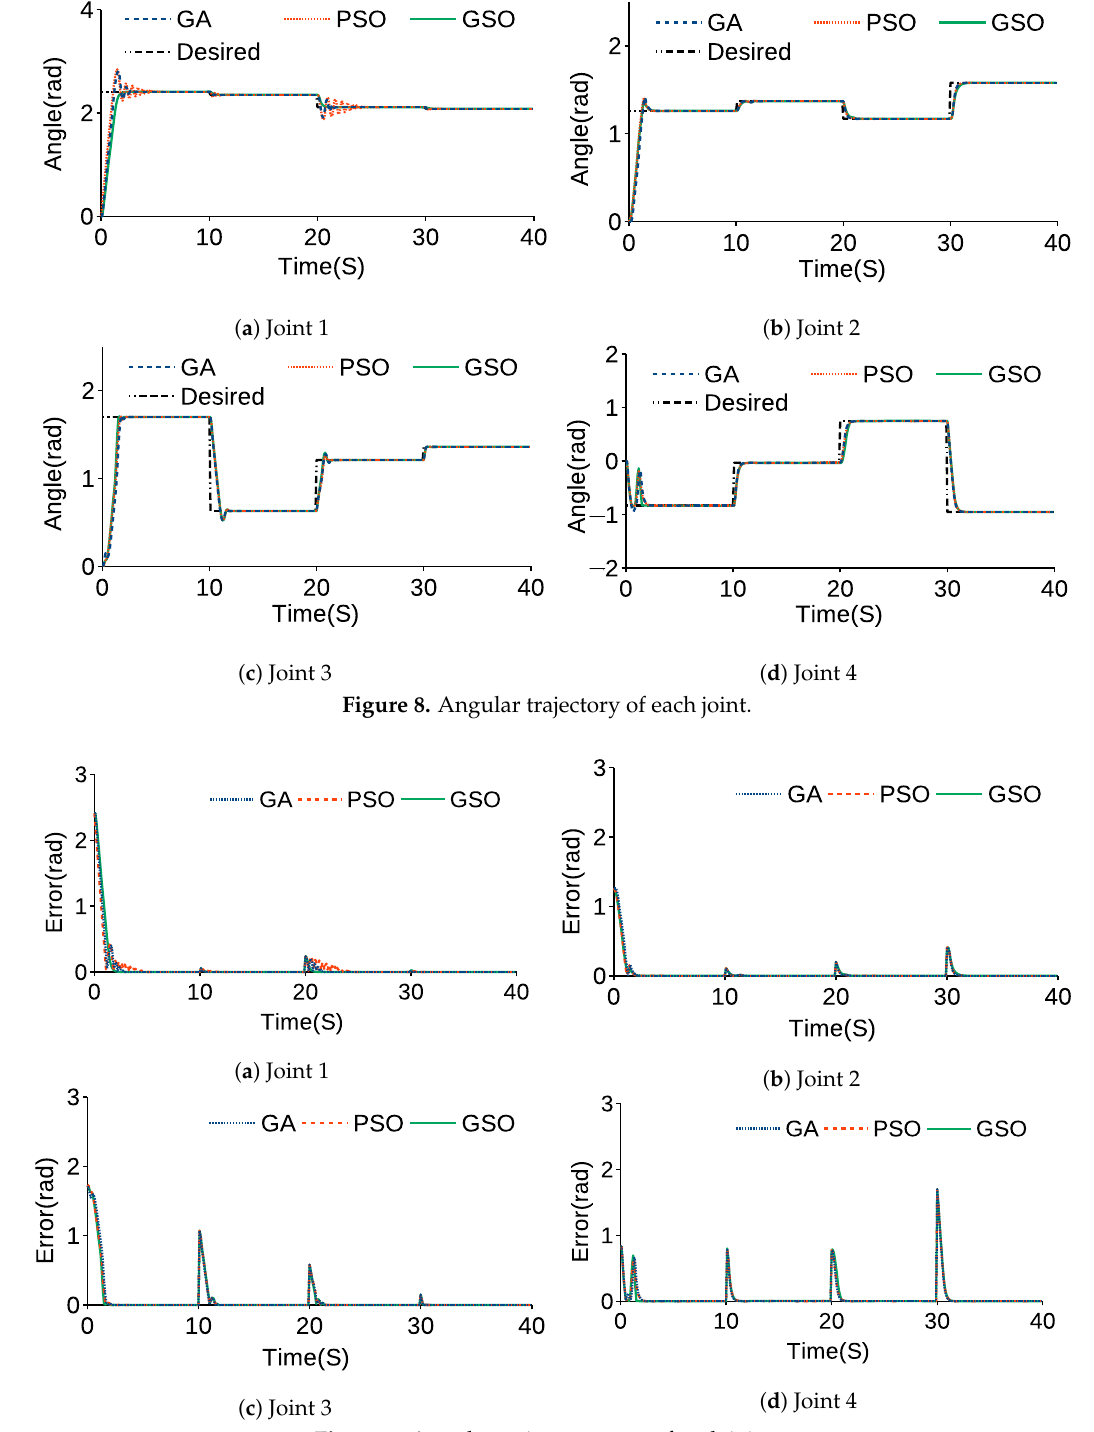
Figure 9. Angular trajectory error of each